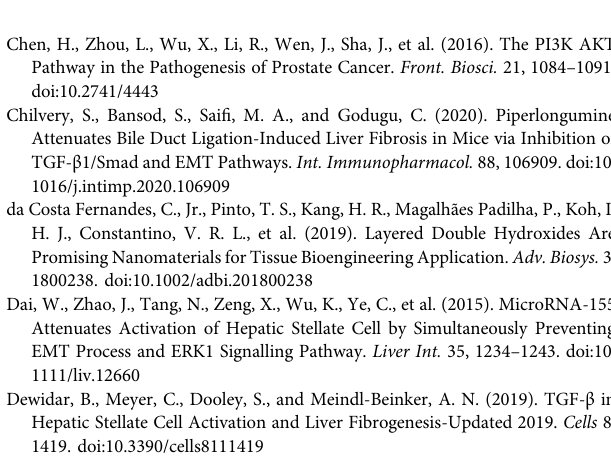
Supplementary Figure S1 | (A) The average particle size and PDI of LDHs and LDHs-SRF in serum. (B) The zeta potential of LDHs and LDHs-SRF in serum. Supplementary Figure S2 | Cellular uptake of LDH-SRF (stained with FITC) at different time points by FACS analysis. Supplementary Figure S3 | The uptake of LDHs-SRF by HSC-T6 cells was observed in TEM. The scale bar: 5 μ m. Supplementary Figure S4 | Immuno fl uorescence imaging of α -SMA expression level (Scale bar = 100 μ